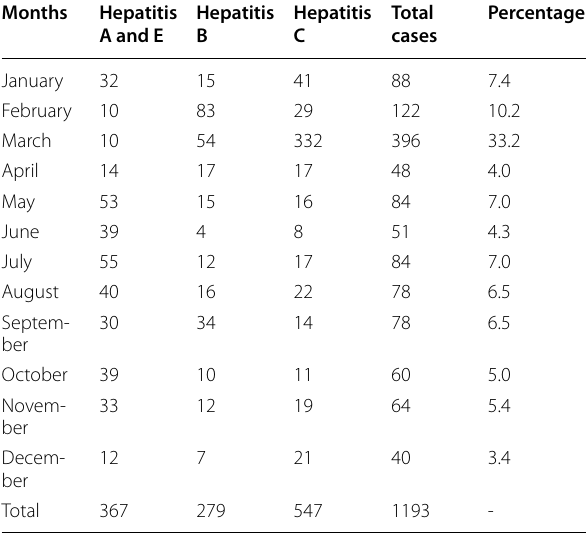
Table 3 Prevalence of different types of viral hepatitis in indoor patients based on the pooled data in the District Dera